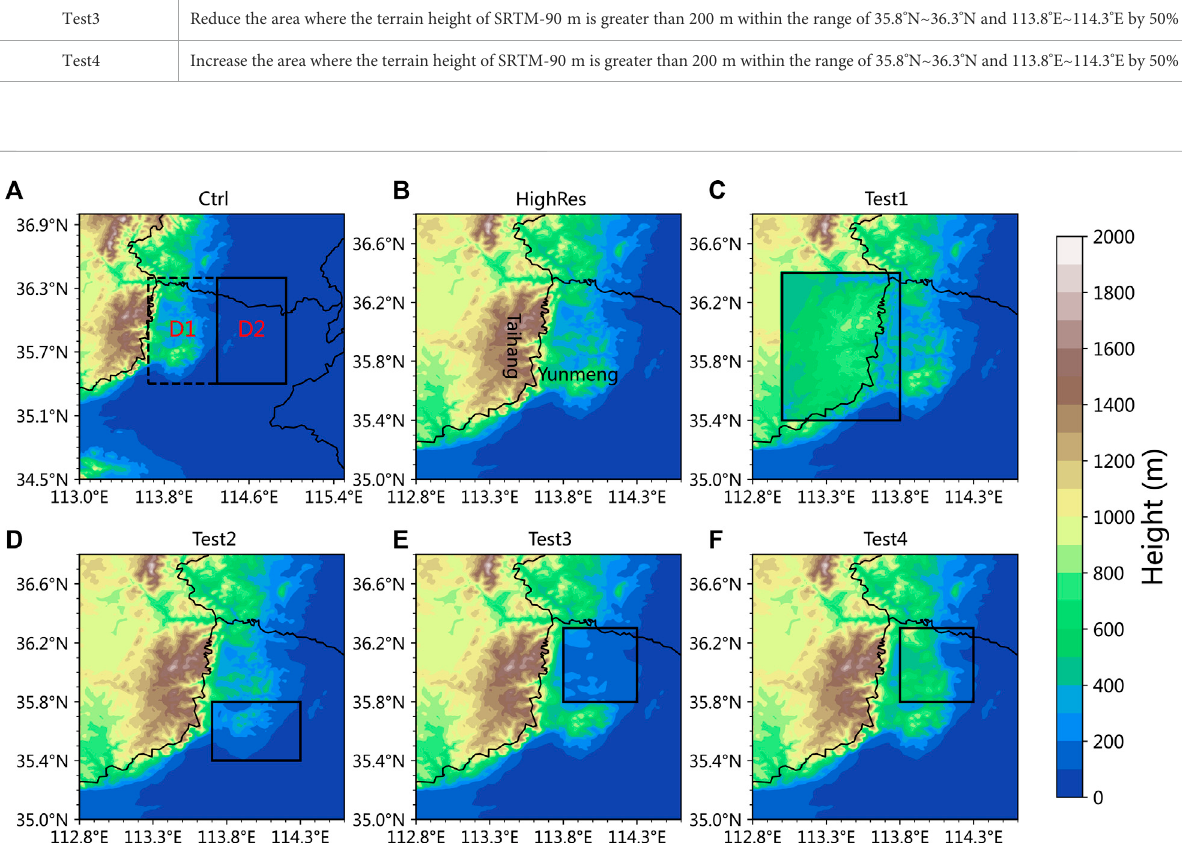
FIGURE 2 Terrainsofthecontrol experiment (A) andcomparative experiment HighRes (B) ,Test1 (C) ,Test2 (D) ,Test3 (E) ,Test4 (F) .Theareawithinthebox indicates the terrain modi fi cation region or study